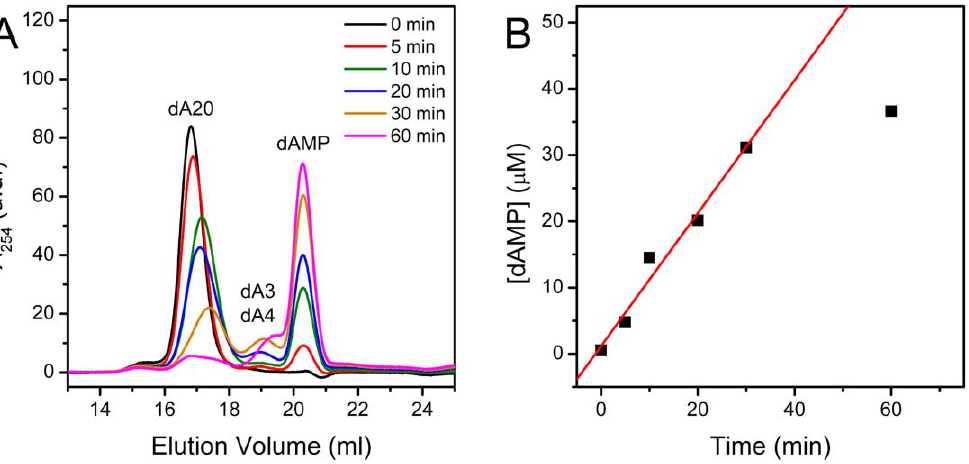
Figure 7. SEC assay of PARN using dA20 as the substrate. (A) The elution profiles of the reaction solutions quenched at different time. The initial dA20 concentration was 2 m M, and the concentration of PARN was 0.1 mg/ml. Details regarding the assay were the same as those in Figure 2. (B) Time-course changes of the dAMP during reaction.